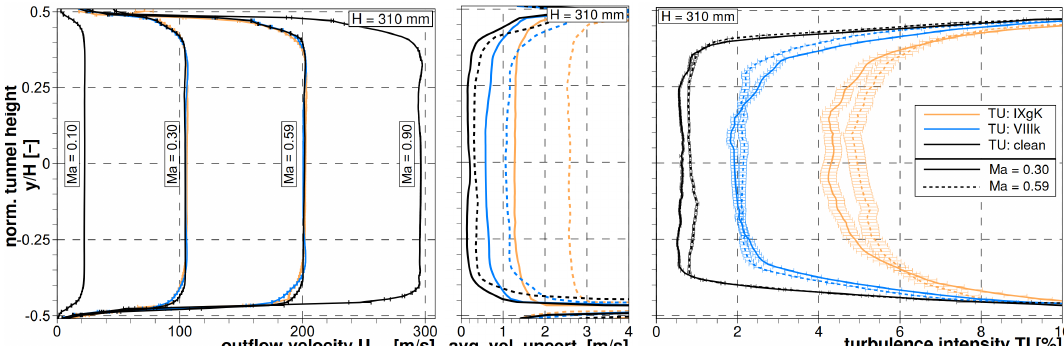
Figure 8. Left : Outflow velocity profiles across the entire channel height of H = 310mm at different operating Mach numbers measured with 2D-3C PIV; center : absolute velocity uncertainty of avg. vector field; right : corresponding turbulence intensity profiles including the local error bars for the clean test section duct (black-clean) and equipped with the turbulence grids (blue-VIIIk; orange-IXgK) at two outflow Mach numbers Ma = 0.3 (solid) and Ma = 0.59 (dashed).